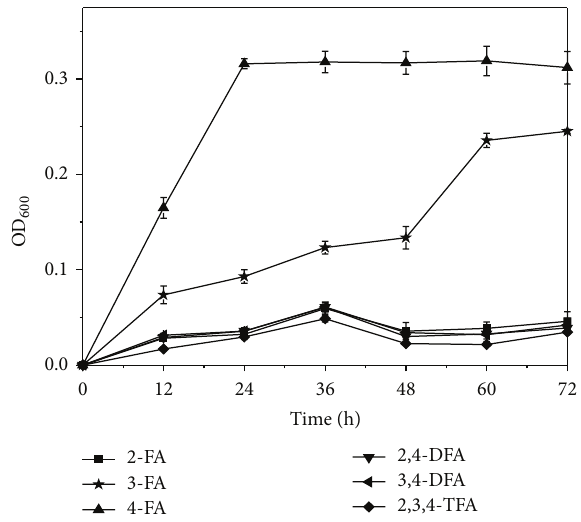
Figure 1: Bacterial growth in the presence of different fluoroanilines (200 mg/L) as the sole carbon and nitrogen source.